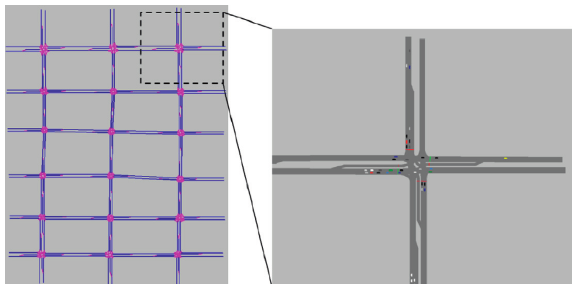
Figure 5: Center line representation of the network and a zoomed- in view of one intersection.